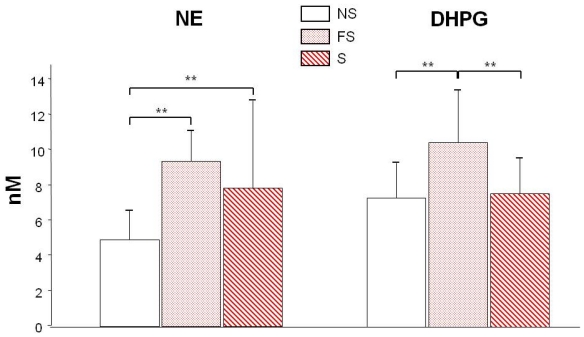
Norepinephrine (NE, left) and its metabolite DHPG (right) in the plasma from non smokers (white bars), former smokers (FS dotted bars), and smokers (S hatched bars) **P < 0.001; Differences between FS and S were not significant (P > 0.05) for NE and the same applies between NS and S for DHPG. NE and DHPG were determined by HPLC with electrochemical detection as previously described [8].